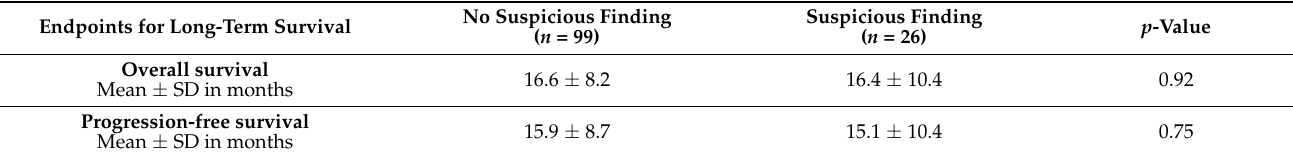
Table 2. Long-Term Survival of NSCLC patients with incidental finding suspicious of additional malignancy versus no suspicious finding at baseline using overall survival and progression-free survival as endpoints for